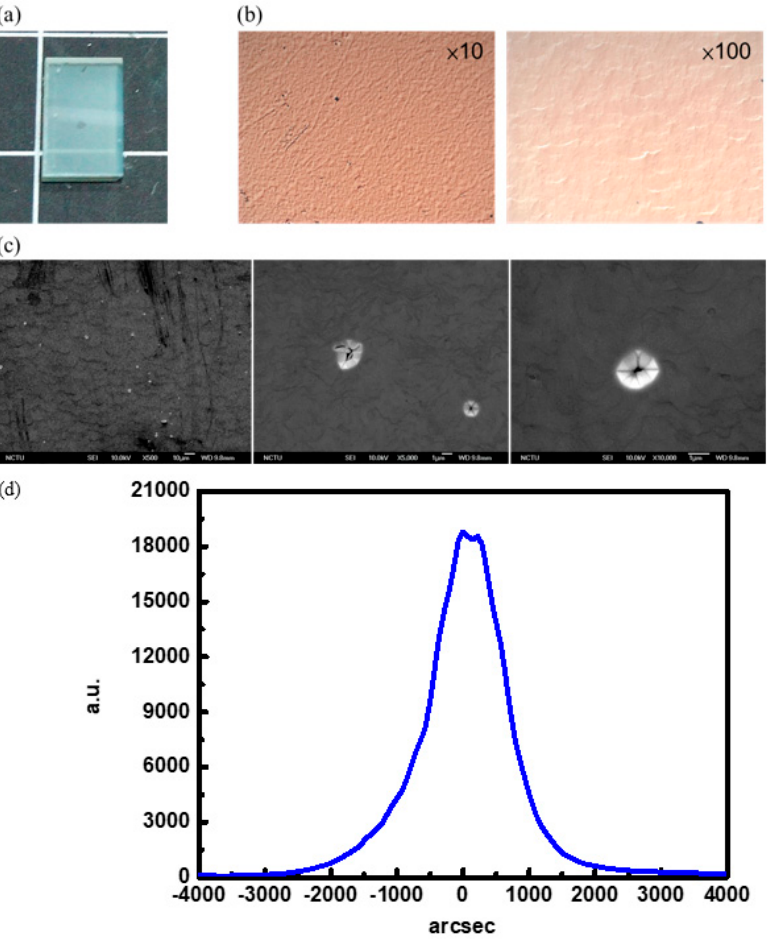
Figure 8. ( a ) Image of the 2- μ m-thick GaN film on the ( − 2 0 1) β -Ga 2 O 3 wafer. ( b ) Optical microscopic images of the GaN film fabricated on PH − 500 substrate with 10× and 100× magnification. ( c ) Plan- view SEM images of the GaN layer on PH − 500 substrate with 500×, 5,000× and 10,000× magnifica- tion. ( d ) Symmetric XRD rocking curves of the (0 0 2) GaN layer on ( − 2 0 1) β -Ga 2 O 3 .